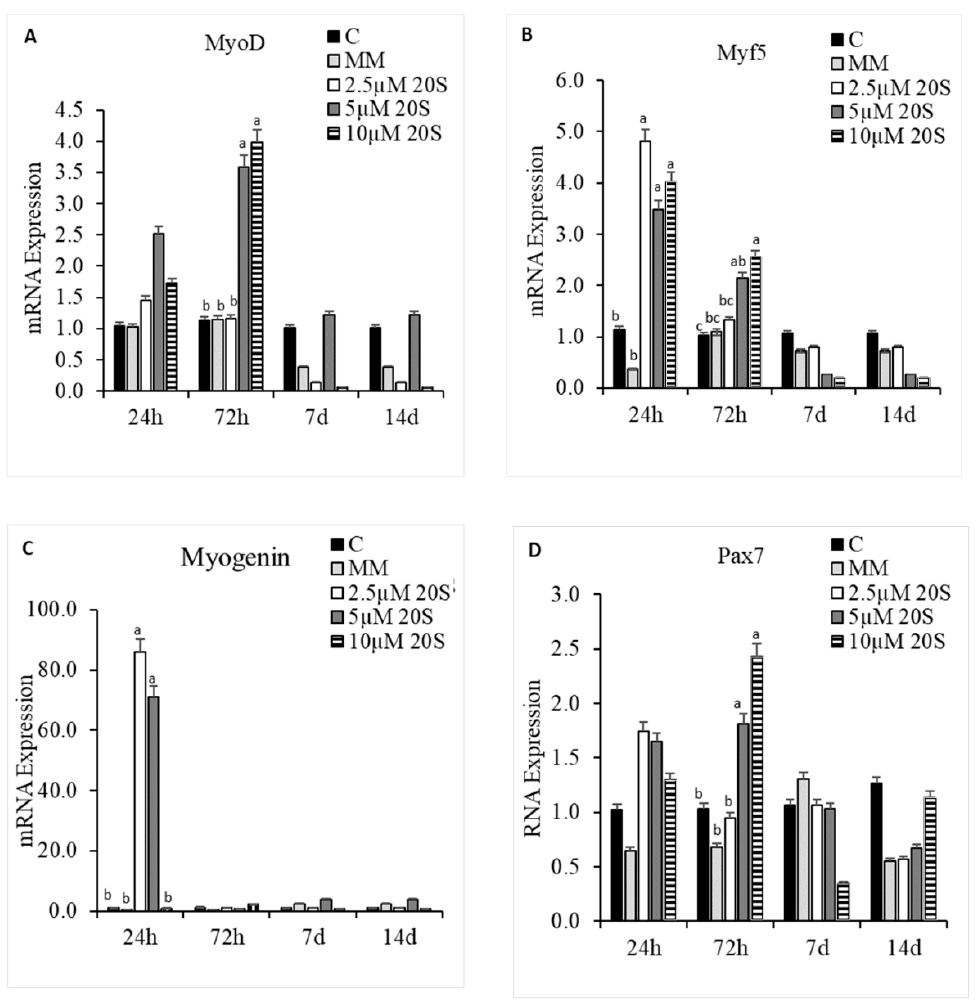
Figure 8. Myogenic effects of 20S oxysterol in mesenchymal stem cells. Relative levels of mRNA expression of osteogenic genes, ( A ) MyoD, ( B ) Myf5, ( C ) Myogenin, and ( D ) Pax7, in compact bone-derived mesenchymal stem cells in chicken (cBMSCs) treated with different levels of oxysterol. cBMSCs were treated with (1) Control (C), (2) myogenic media (MM) containing DMEM with 5% Horse Serum, 10 µM Hydrocortisone, and 0.1 µM DXA, (3) MM + 2.5 µM 20S, (4) MM + 5 µM 20S, or (5) MM + 10 µM 20S. Cells were harvested at 24 h, 72 h, and 7 d after treatment. RNA was isolated, reverse transcribed to cDNA, and qRT-PCR was conducted to analyze osteogenic gene expression. GAPDH was used as housekeeping genes. Fold changes in gene expression relative to the control were calculated using the −ΔΔ Ct method. Bars represent mean ± SEM of triplicate determinations. Within each harvest period, bars without a letter (a–b) in common are significantly different ( p < 0.05) when analyzed with Tukey’s test.